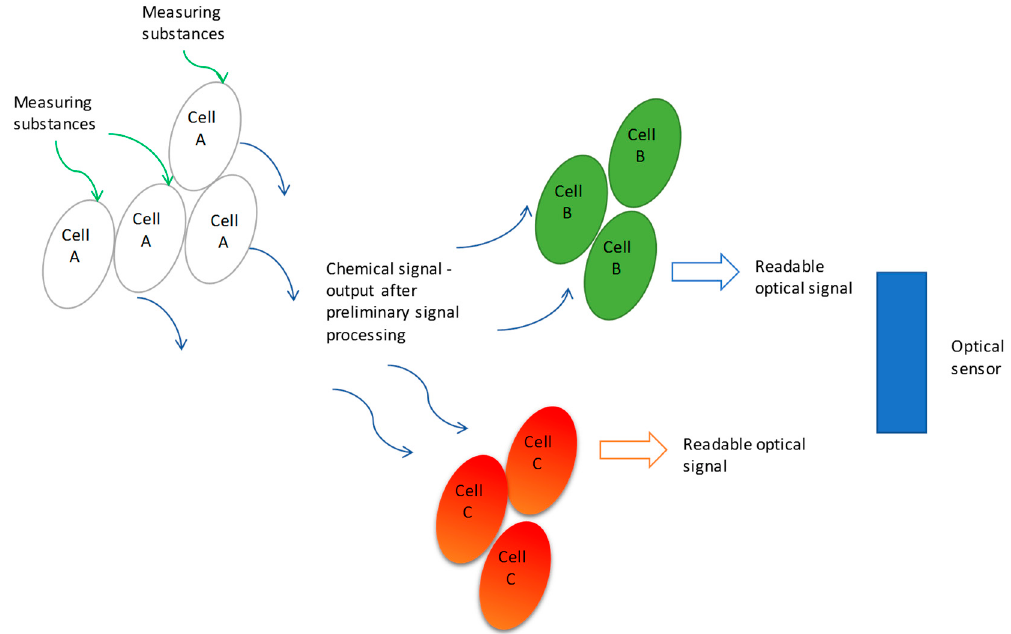
Figure 3. Multi-sensor cell systems with several stages of data processing.